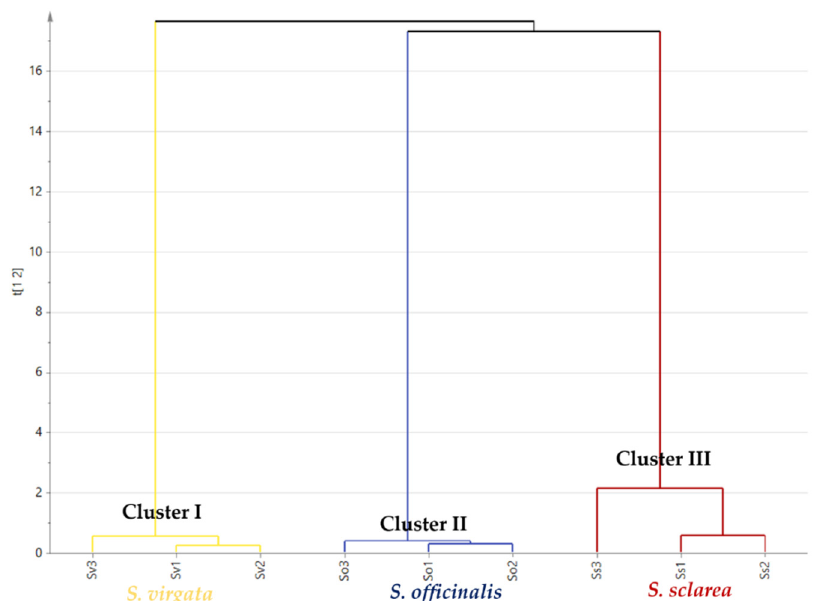
Figure 2. HCA dendrogram based on GC-MS chemical profile of the essential oils of different Salvia species as displayed in Table 1. S. officinalis (So), S. virgata (Sv) and S. sclarea (Ss).